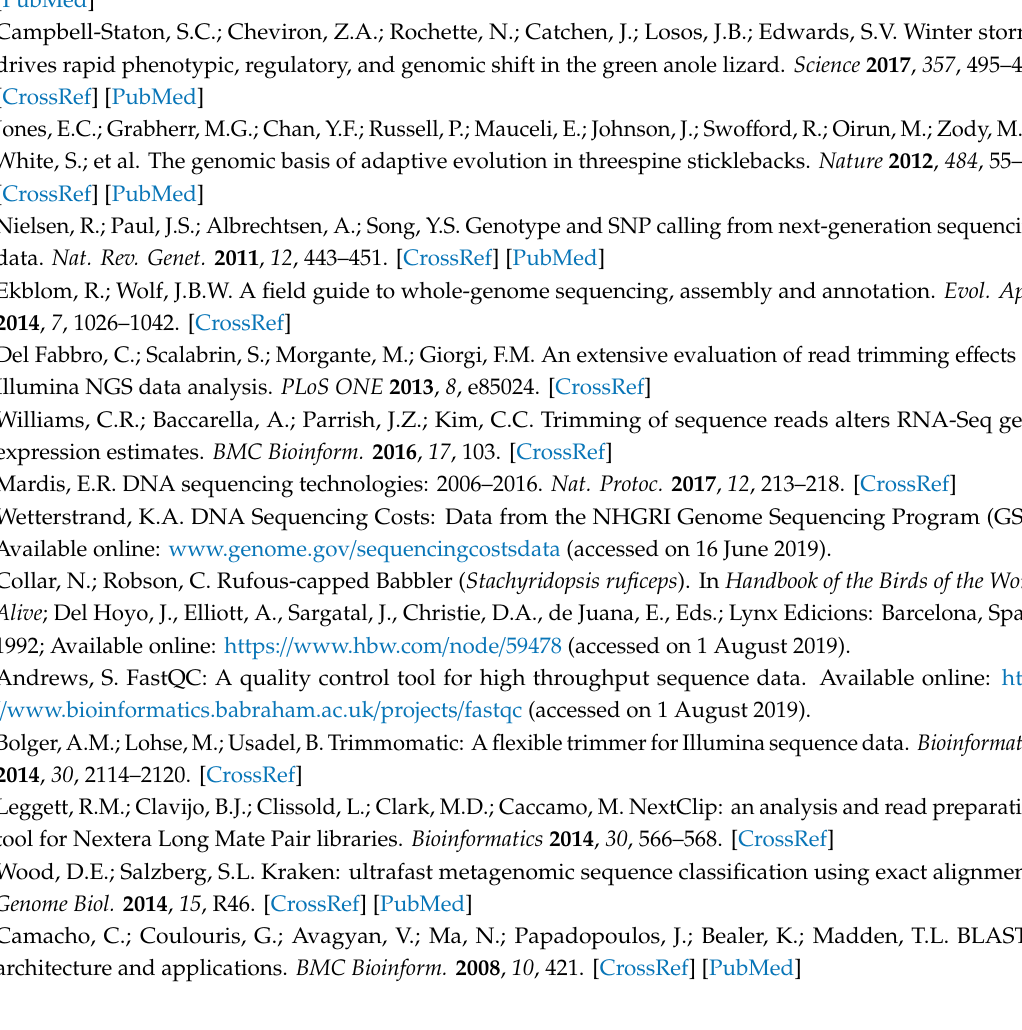
Figure S1: D-GENIES plots of alignments between the rufous-capped babbler and three avian genomes; Figure S2: Jupiter plots of alignments between the rufous-capped babbler and three avian